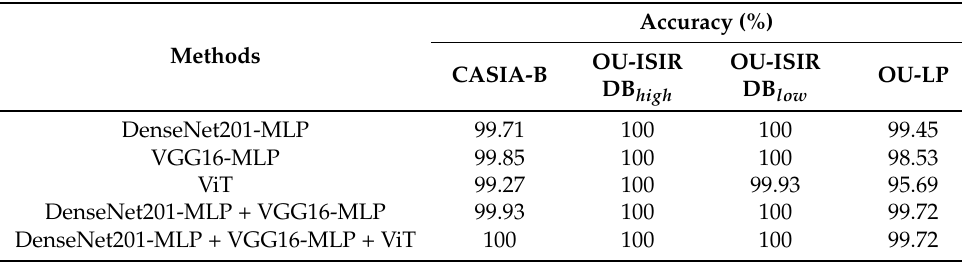
Table 2. Experimental results of the different ensemble